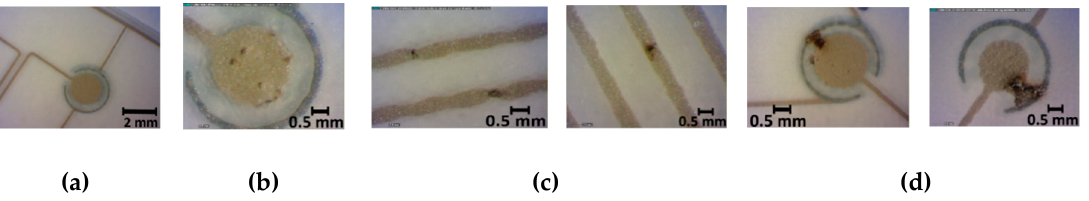
Figure 8. ( a ) Normal sensor, ( b ) Fault in the sensor top electrode (pole), ( c ) Cut in the sensor tracks, due to short circuits during the poling procedure, ( d ) Shortcuts between sensor tracks.